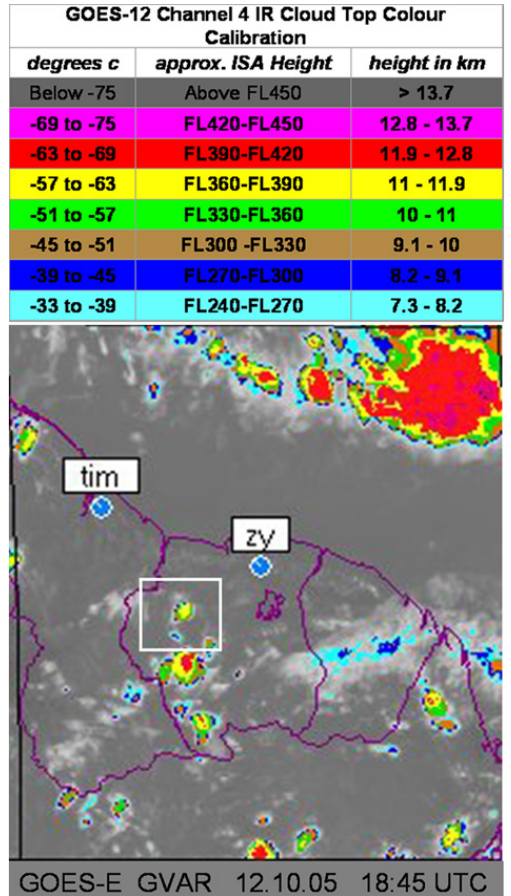
Figure 5. GOES-12 infrared channel satellite image of the GABRIEL observation area from 12 October, 18:45UTC. The cloud top height is colour coded as described in the table above the image. The white square marks the investigated isolated thun- derstorm